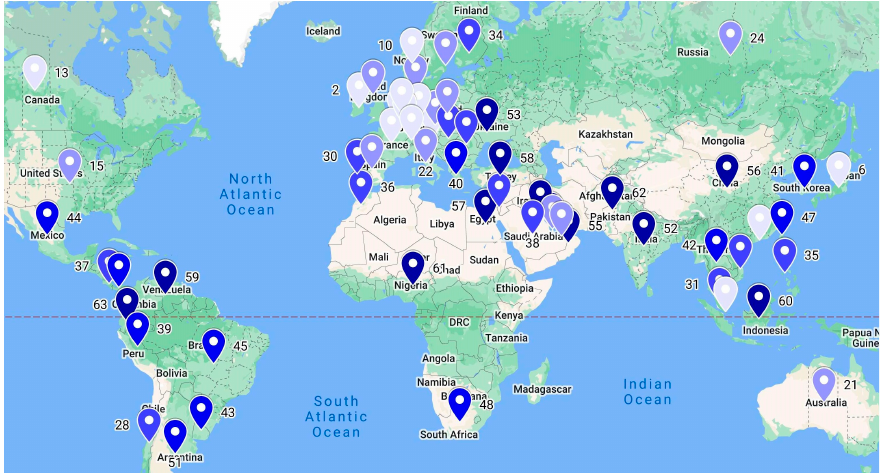
Figure 1. Ranks of countries by the quantity of vacancies in BIM dated 8 September 2022 (https://www.google.com/maps/d/edit?mid=1gd-U8SeJRDjzIaSpHx0_kqXLuefqZGw&usp=sharing/ accessed on 19 November 2022). The lighter the color is, the higher is the need for specialists in BIM.